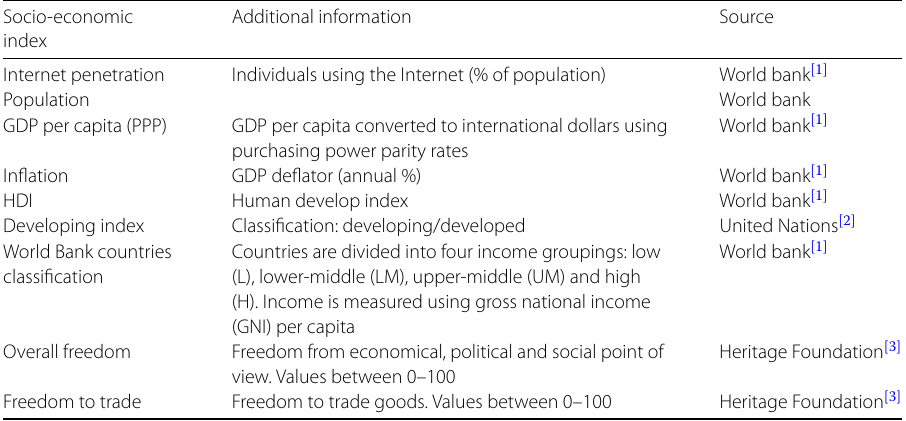
Table 3 Summary of socio-economic indexes used Socio-economic